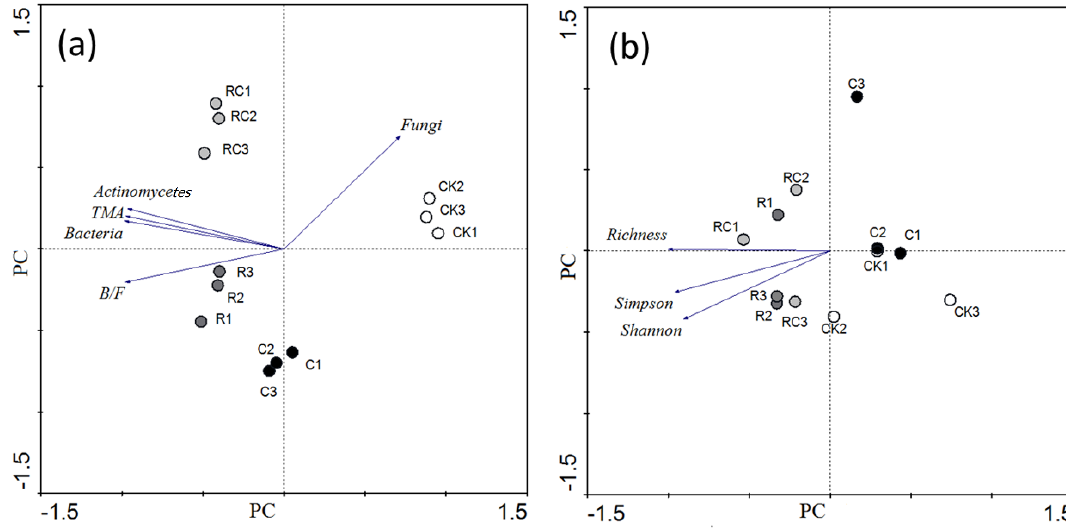
Figure 5. Principal component analysis (PCA) of ( a ) contributions of rice straw and biochar to the microbial abundance and ( b ) microbial diversity.